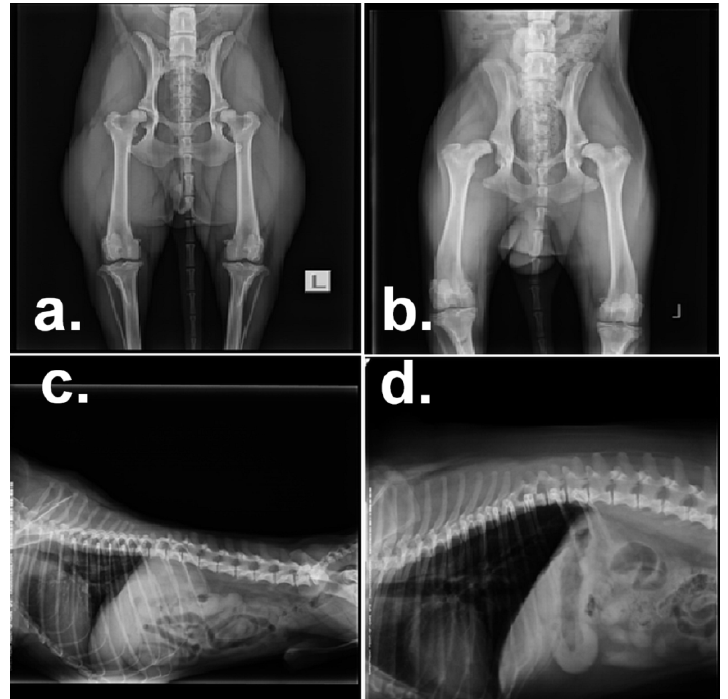
Figure 1. Pathological entities found in dogs exhibiting pain. ( a ). Hip dysplasia Mixed breed Labrador Saint Bernard, grade 2–3 (right); grade 1 (left). ( b ). Hip dysplasia Labrador retriever; femoral head: luxation (right); sub-luxation (left). ( c ). Suspicion of intervertebral disc disease narrowing Rusky toy (space L4–L5). ( d ). Intervertebral disc disease narrowing Mops (spaces T6–T7 and T10–T11).